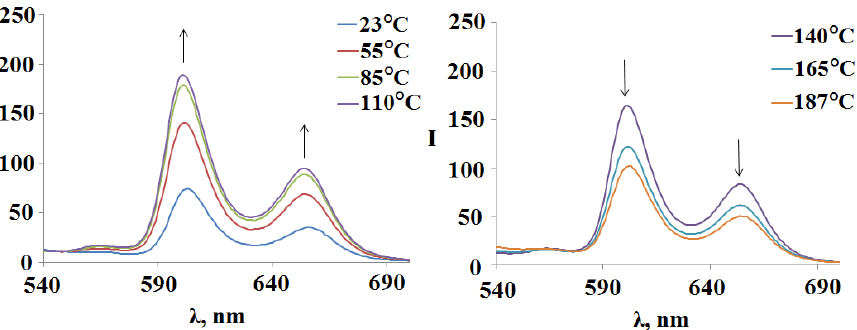
Figure 12. Change in the fluorescence spectra of the polymer 4 ((Sn(L − Cu) 2 P) 4 (PdCl 2 ) 4 ) n when the temperature of the DMSO solution varies from 23 ◦ Cto 187 ◦ temperature of the DMSO solution varies from 23 °Cto 187 °C.